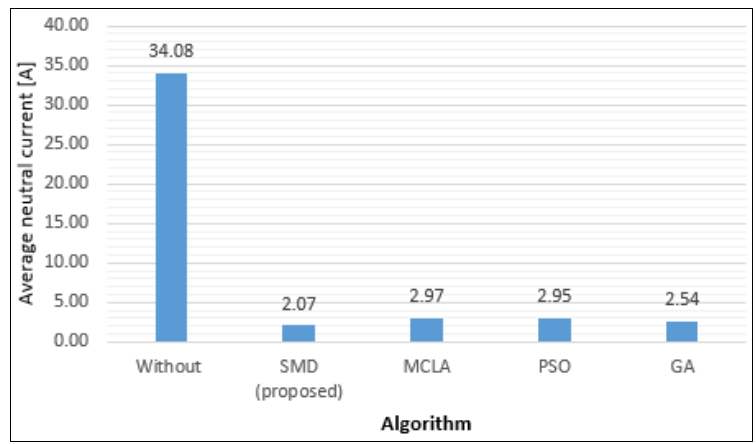
Figure 14. Comparison between the average values of neutral current in the first branch, SP-Pillar 8, calculated with different algorithms.